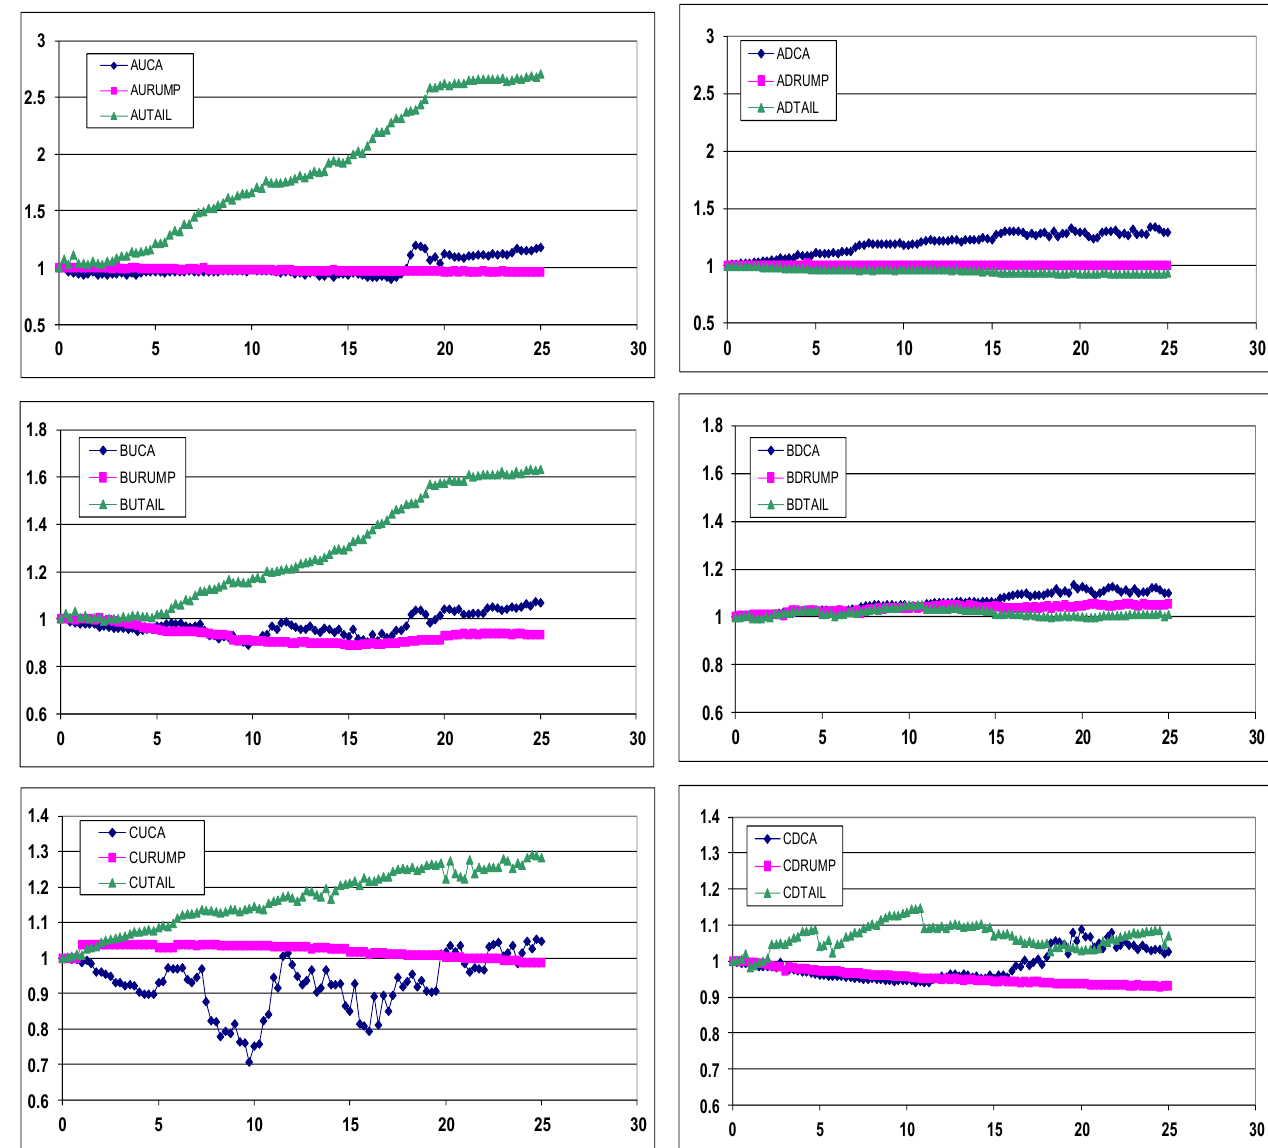
Figure 3: Squirrel monkey calf (CA), rump (RUMP), and tail (TAIL) volume changes during short